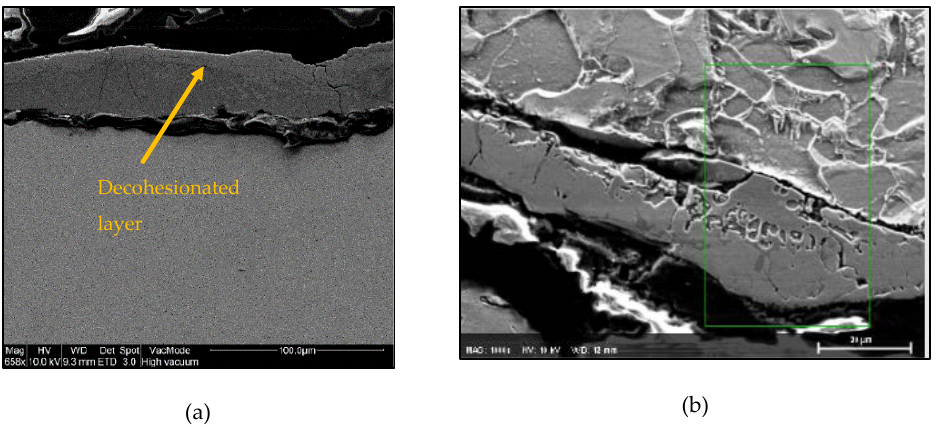
Table 3. Definition of parameters used for each sample and